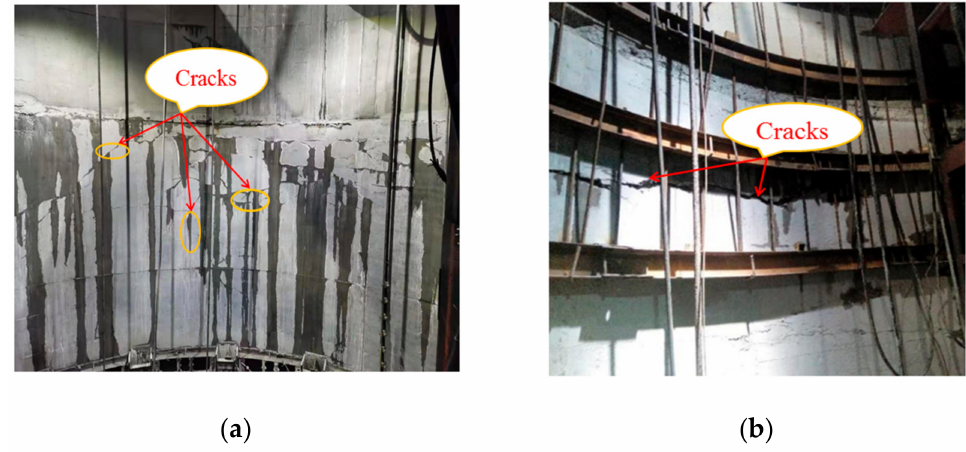
Figure 1. The cracks of high-strength concrete in shaft lining: ( a ) Temperature cracks caused by temperature stress; ( b ) Rupture cracks caused by uneven freezing